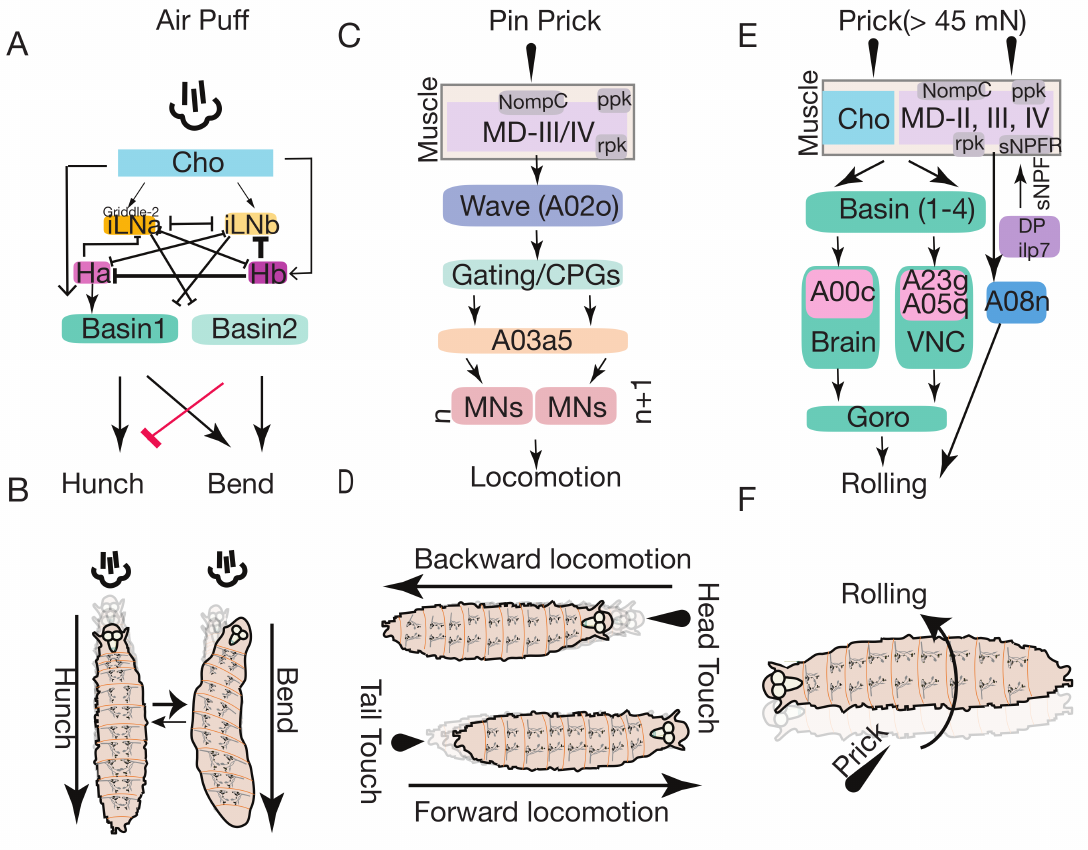
Figure 5. Neural circuit involved in mechanosensory-nociception. ( A ) The neural circuitry involved in promoting hunching and bending in response to a gentle air puff (adapted and modified from [30]). ( B ) Schematic depicting larval hunching and bending in response to an air puff. ( C ) The neural circuitry involved in location-specific, gentle touch-mediated forward and backward locomotion (adapted and modified from [24]). ( D ) Schematic depicting touch-mediated forward and backward locomotion. ( E ) The neural circuitry involved in noxious, touch-mediated rolling behavior. ( F ) Schematic showing larval rolling in response to a noxious mechanical touch (>45 mN [104]) (adapted and modified from